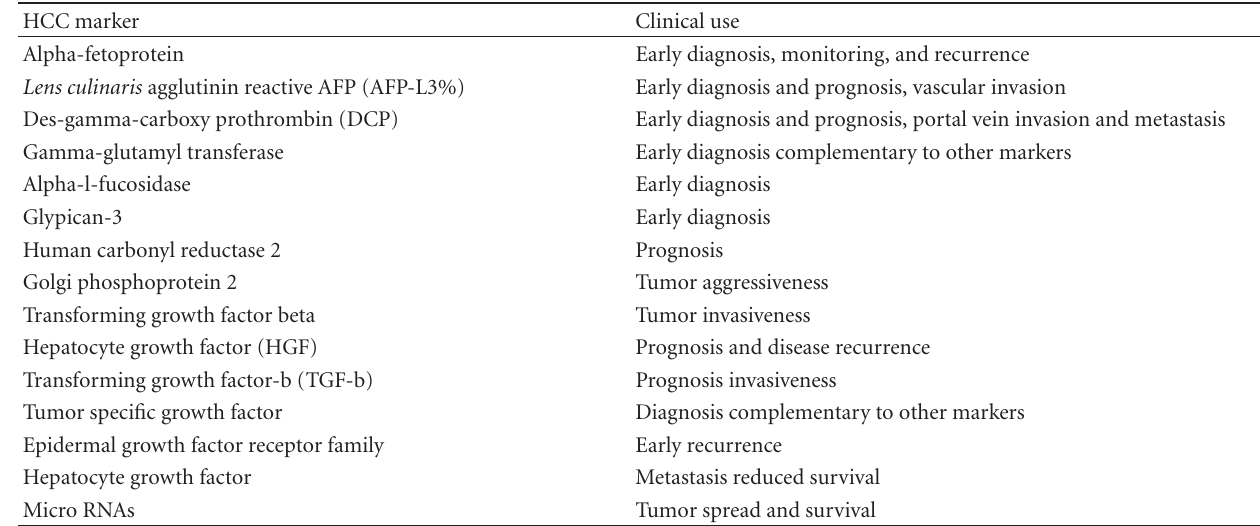
Table 2: Various HCC biomarkers and their clinical